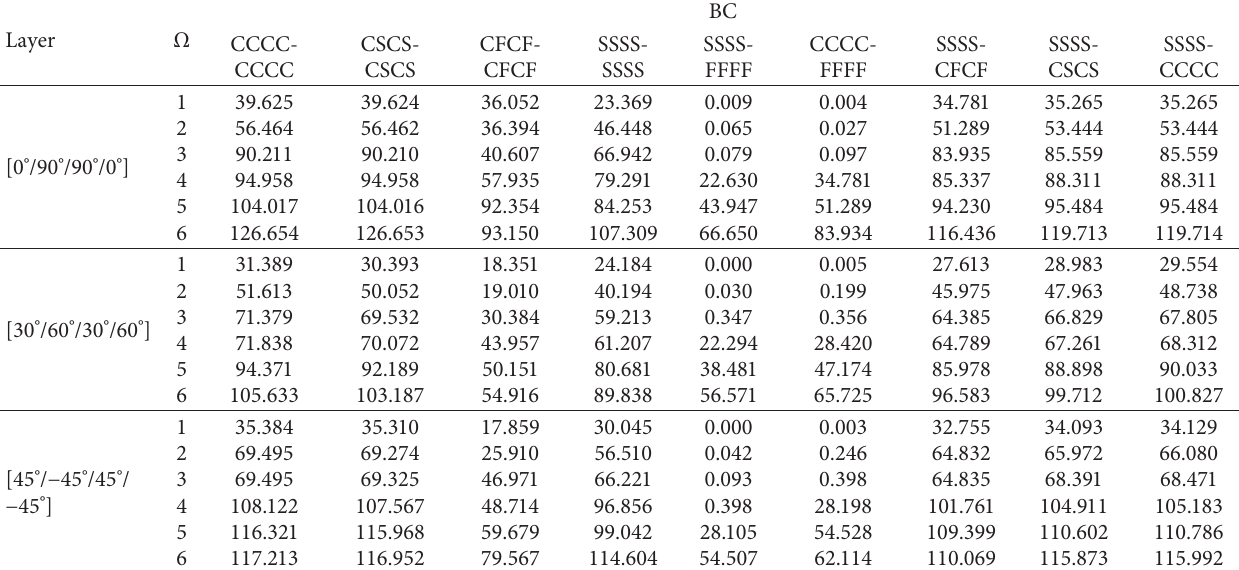
Figure 4: Comparison between the present solutions and experimental results. (a) Present solutions. (b) Experimental results. Table 4: Frequency parameters Ω for an LCDPS with different layer scheme and classical